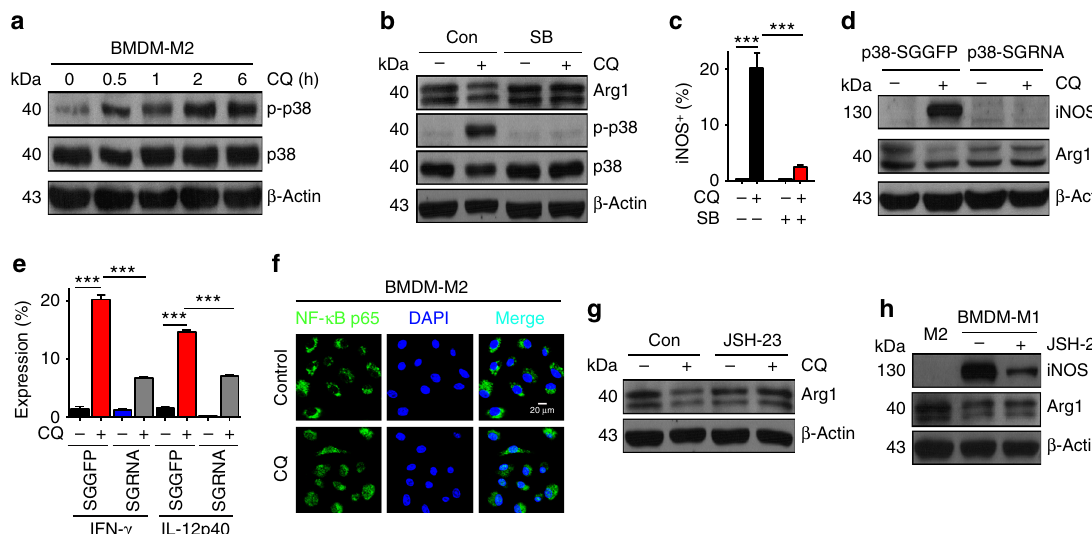
Fig. 4 M1 macrophages are induced by CQ-activated p38 and NF- κ B. a The expression of p-p38, total p38, and β -actin in BMDM-M2 cells treated with CQ at indicated time points were analyzed by western blotting. b , c The expression of Arg1, p-p38, total p38, and β -actin was quanti fi ed by western blotting ( b ) and the expression of iNOS was analyzed by fl ow cytometry ( c ) in BMDM-M2 cells that were pretreated with 10 μ M SB203580 or not for 2 h before addition of CQ or PBS ( n = 3). d The expression of iNOS, Arg1, and β -actin in p38-SGGFP and p38-SGRNA Raw264.7 cells with or without CQ treatment were analyzed by western blotting ( n = 3). e Quanti fi cation of IFN- γ and IL-12p40 in p38-SGGFP and p38-SGRNA Raw264.7 cells with or without CQ treatment were analyzed by fl ow cytometry ( n = 3). f NF- κ Bp65 in BMDM-M2 cells with or without CQ treatment was examined by confocal fl uorescent microscope. Green, NF- κ Bp65; blue, DAPI. Scale bar, 20 μ m. g The expression of Arg1 and β -actin in BMDM-M2 cells that were pretreated with 10 μ M JSH- 23 or not for 2 h before addition of PBS or CQ were analyzed by western blotting. h The expression of iNOS, Arg1, and β -actin were analyzed by western blotting in BMDM-M2 and BMDM-M1 cells that had been pretreated with 10 μ M JSH-23 or not for 2 h. Data shown are representative of three independent experiments and error bars represent mean ± SEM. * P < 0.05; ** P < 0.01; *** P < 0.001 (Student ’ s t